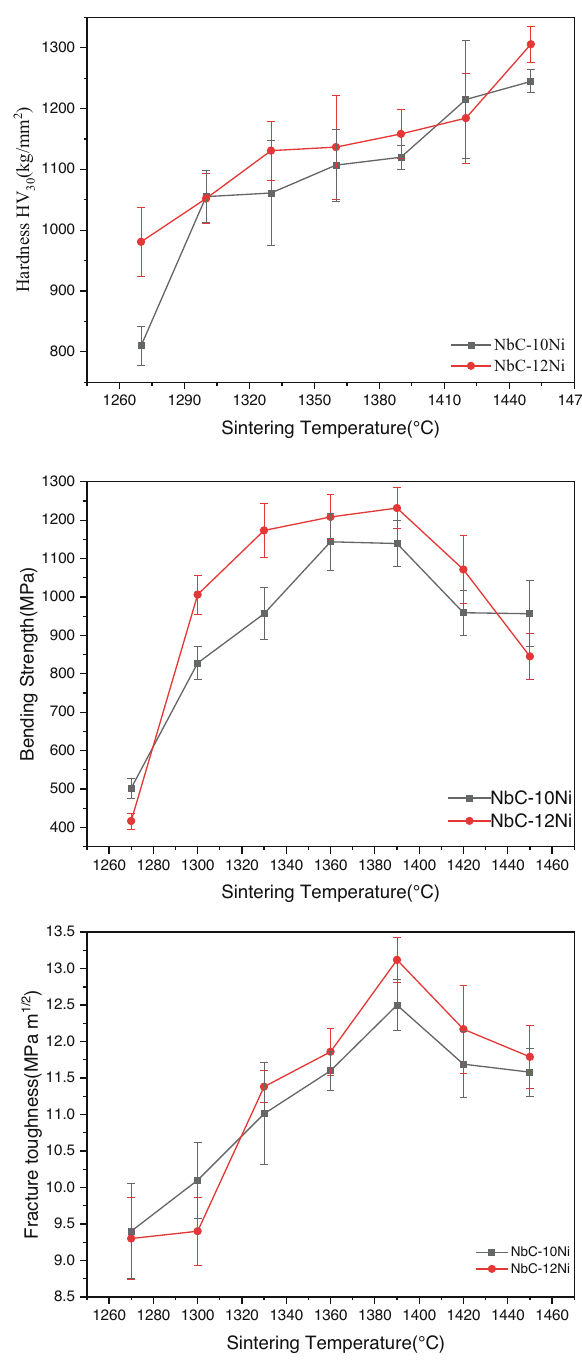
Figure 8: Mechanical properties of NbC – Ni cermets at di ff erent sintering